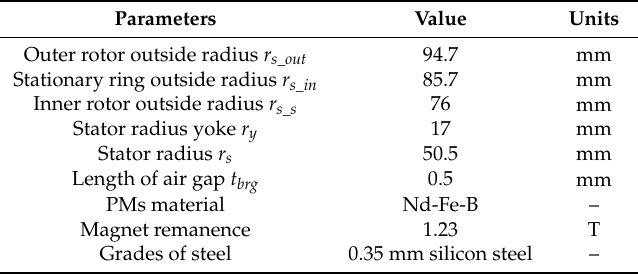
Table 1. Fixed design parameters of the